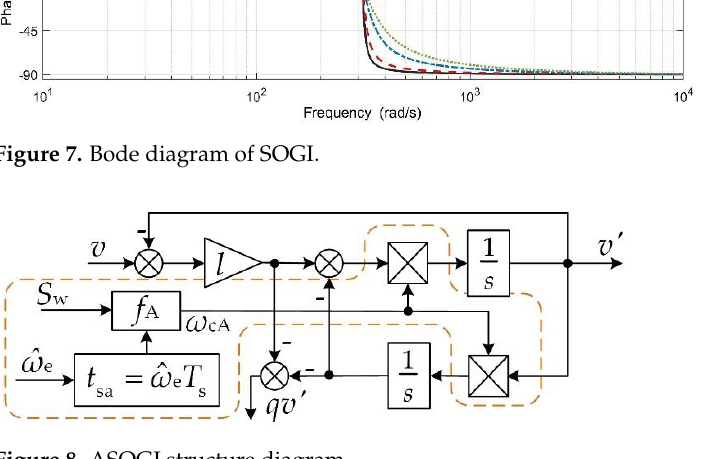
Figure 8. ASOGI structure diagram.